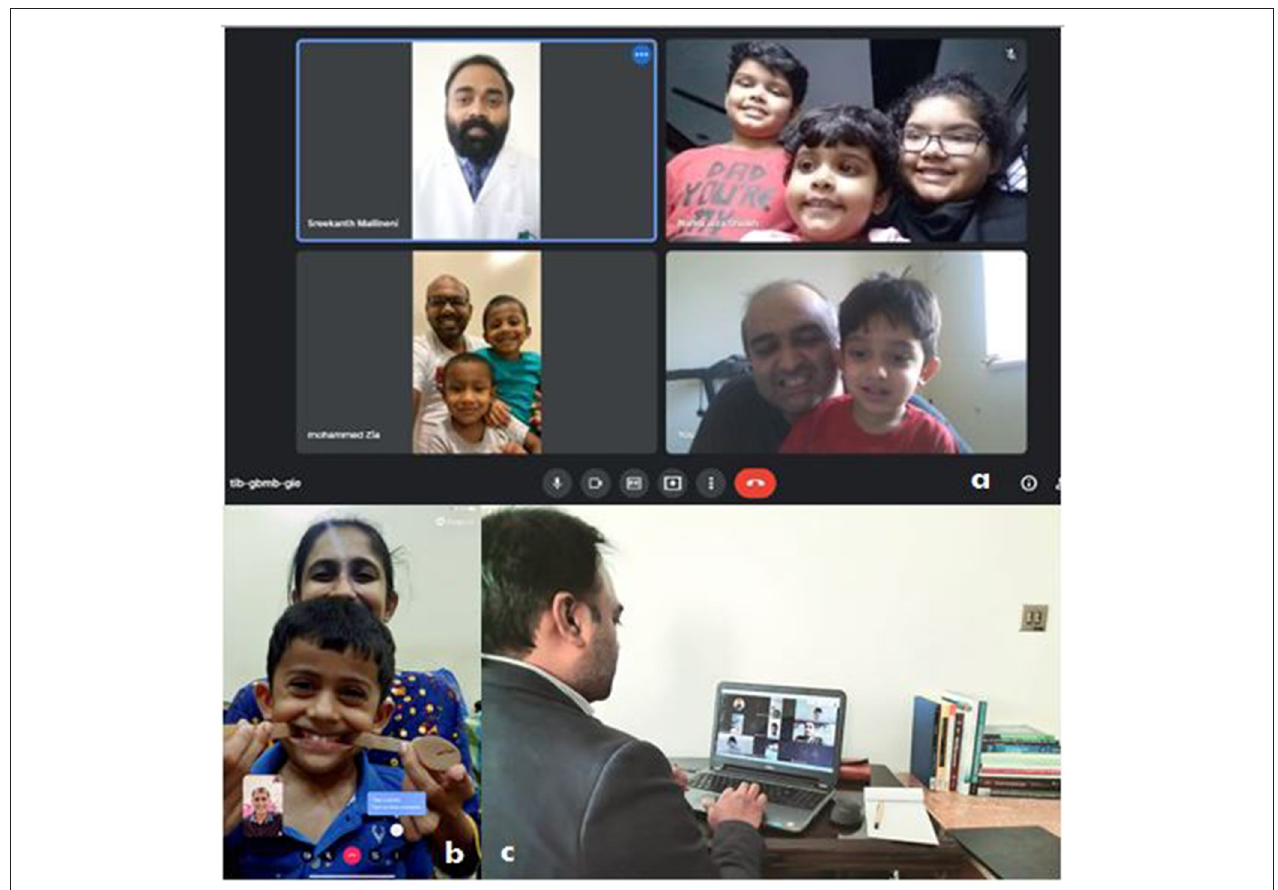
FIGURE 1 | (a) Virtual patient consultations, (b) parental guidance, and (c) student meetings during COVID-19 pandemic outbreak on pediatric